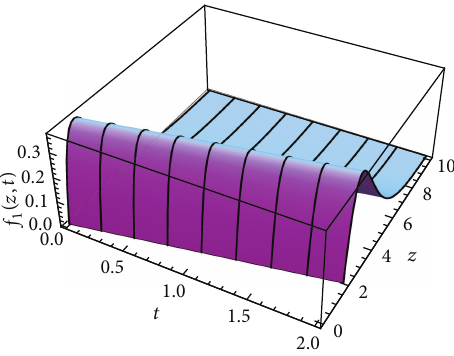
Figure 4: Plot of 𝑓 1 (𝑧,𝑡) given by (61) in Example 13 at different values of 𝑡 = {0, 0.25, 0.5, . .. ,2} (corresponding to the solid lines) in the case that Ga (2;1) , 𝑏 = 1 , and 𝑡 0 = 0